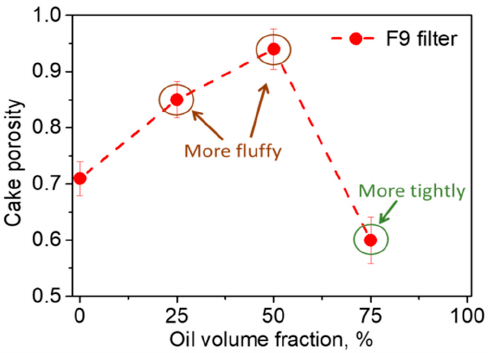
Figure 8. Cake porosity ε of clogged F9 filters under different oil-coated particle conditions.